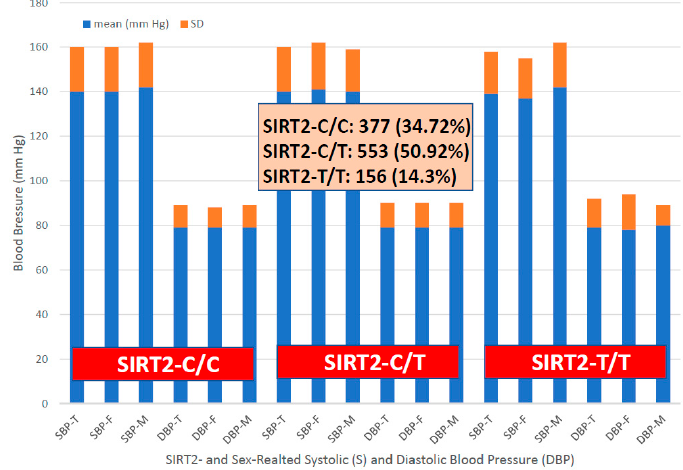
Figure 9. SIRT2 -related blood pressure values in Alzheimer’s disease.